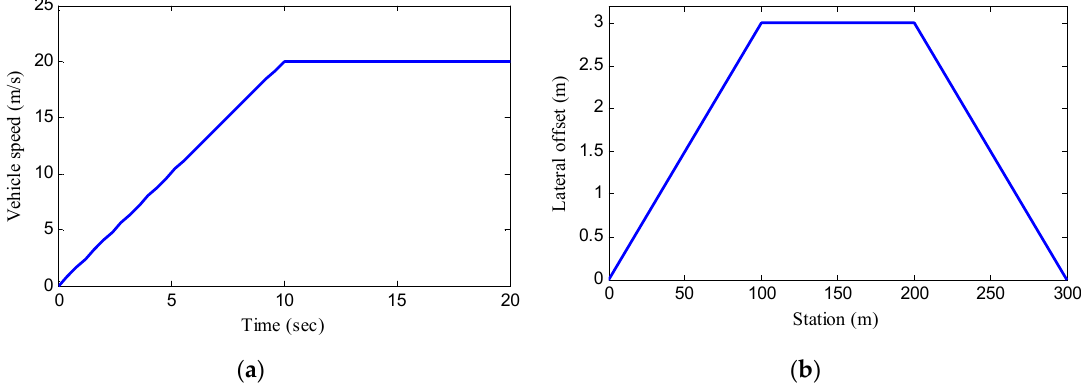
Figure 7. Simulation condition in case study 1. ( a ) Planned vehicle speed; ( b ) Planned double lane change